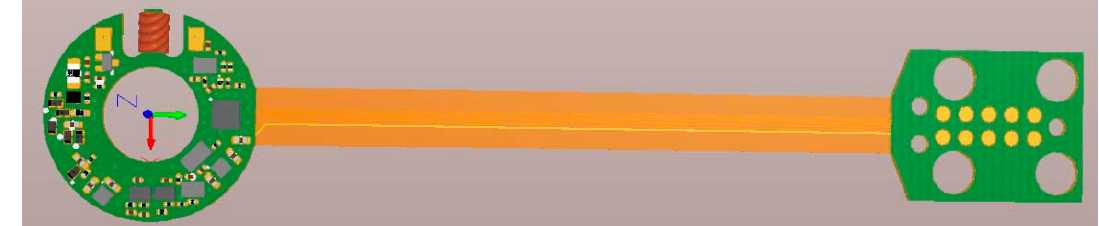
Figure 5. Final Semi-Rigid PCBD design result with flex interface for FPGA